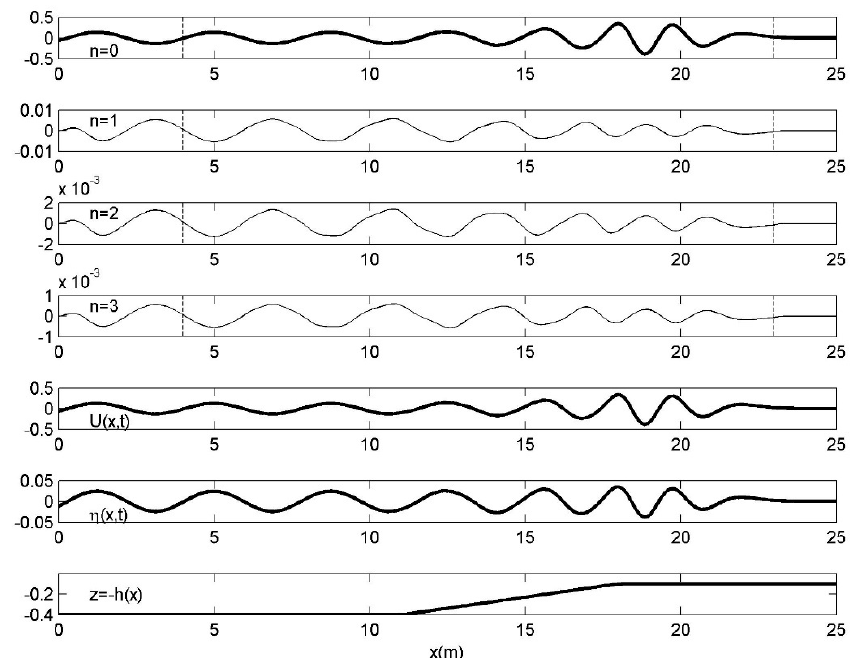
Figure 7. Results obtained by the present linearized CMS for harmonic incident waves of period T = 2 s and a height of 5 cm propagating over a linear upslope characterized by bottom slope 4.5%. The first 4 subplots present the calculated modes U n ( x ; t ), n = 0, 1, 2, 3 at a given time instant. The vertical dashed lines indicate the absorbing (relaxation) zones. The last three subplots show (using thick lines) the velocity field U ( x , z = 0; t ) on the mean free surface ( z = 0) and the free surface elevation η ( x ; t ) at the same instant, and finally the sloping bottom topography.